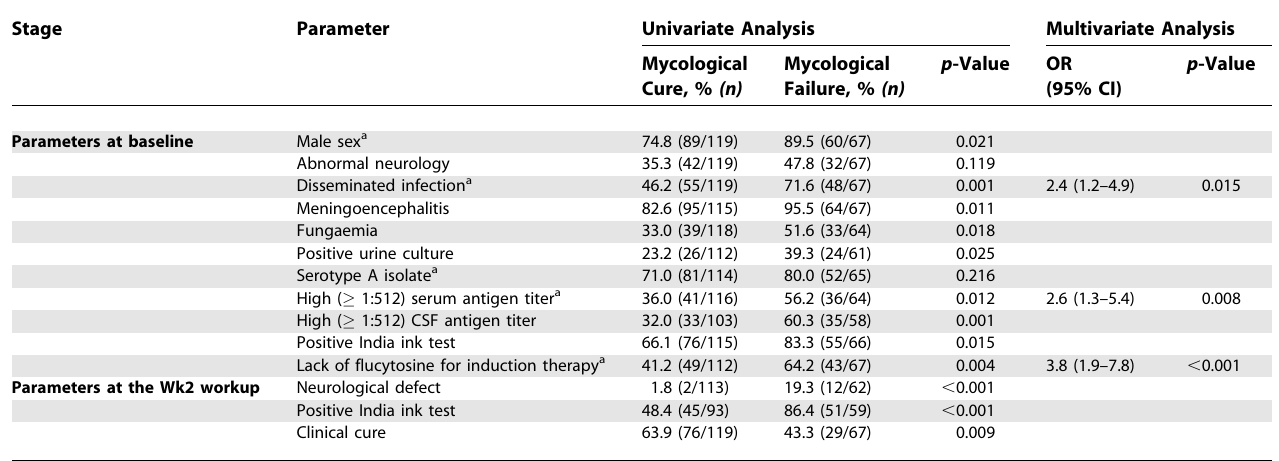
Table 4. Parameters Associated with Mycological Failure at the Wk2 Workup in 186 HIV-Positive and -Negative patients with Cryptococcosis (All Cases): Univariate and Multivariate Analyses